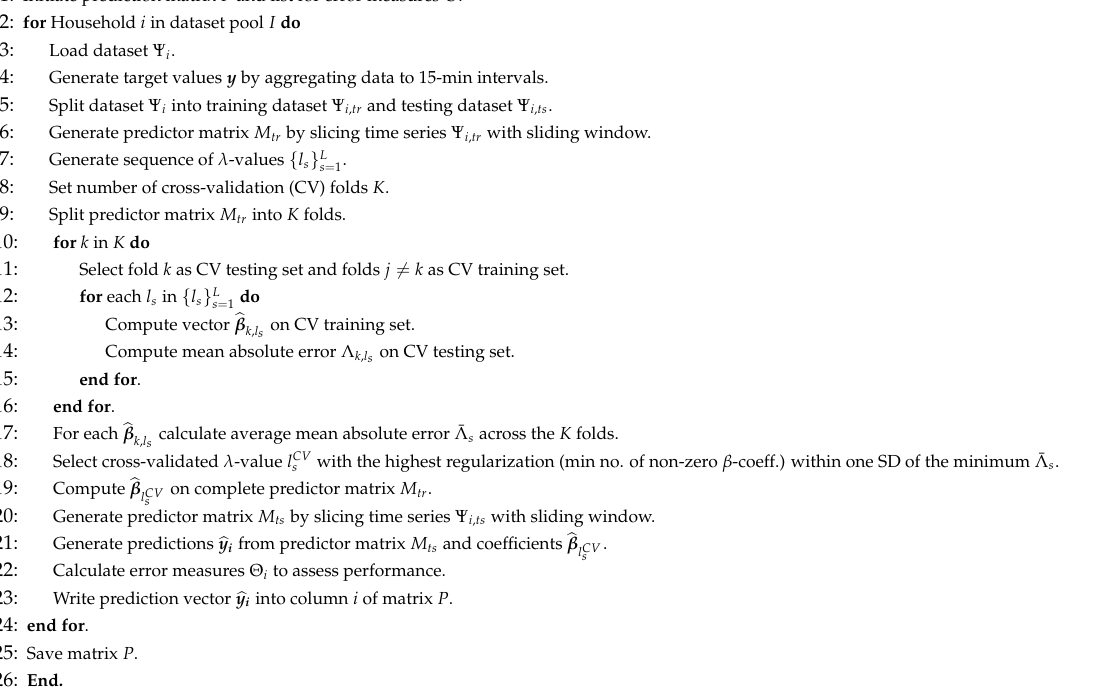
Procedure 2 Cross-validated selection of λ for LASSO and